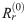
Combinatorial Laplacian score for a set of binary 1-point (a) and 2-point (b) features on a Čech complex. Features in this example can take values 0 (blue) or 1 (red). The 0-dimensional combinatorial Laplacian score Rr(0) was computed for each of the features shown in (a). These features assign values to the nodes in the complex. Rr(0) can be expressed as a sum over edges (S1 Note), where edges that connect vertices on which the feature takes a high value contribute little. Features that take high values on highly connected regions of the simplicial complex therefore have lower values of Rr(0) than features that take high values on disconnected nodes. Analogously, the 1-dimensional combinatorial Laplacian score Rr(1) was computed for each of the features shown in (b). In this case, features are evaluated on the edges of the simplicial complex. Features that take high values on edges that form non-contractible loops in the simplicial complex have lower values of Rr(1) than features that take high values on disconnected or contractible paths.